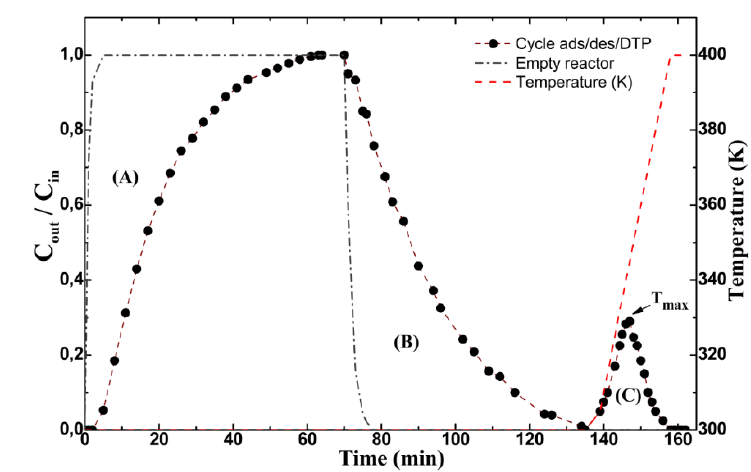
Figure 2. Profile of o -xylene concentration variation at reactor outlet obtained with bentonite clay during the different experiment steps: isothermal adsorption then desorption followed by DTP.